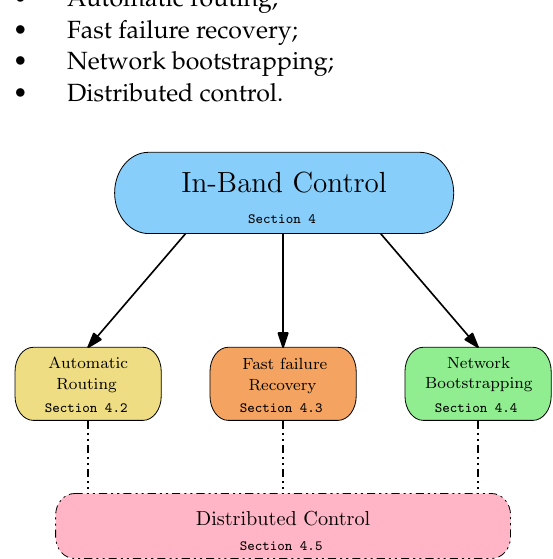
Figure 5. Main categories of the